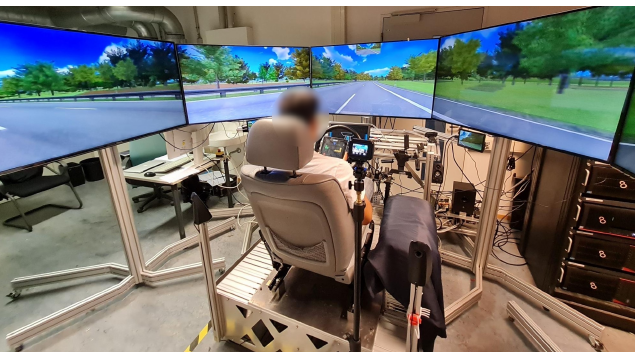
Figure 3. Driving simulator used in this